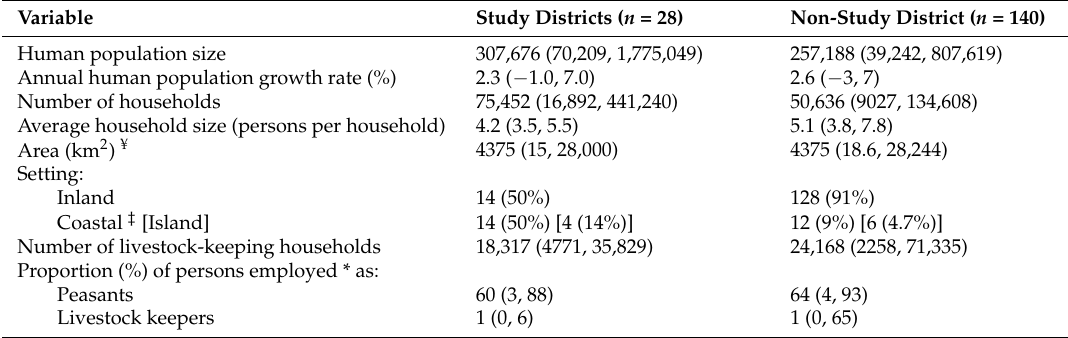
Table 1. Characteristics of study and non-study districts in Tanzania. Continuous variables are summarised by the mean (range) and categorical variables by the number (%). Variables were either extracted from the national census [16] or from district shapefiles from the Tanzania National Bureau of Statistics (NBS) website [19]. These variables were tested using ordinary least squares regression to assess the best variables for predicting numbers of dogs in